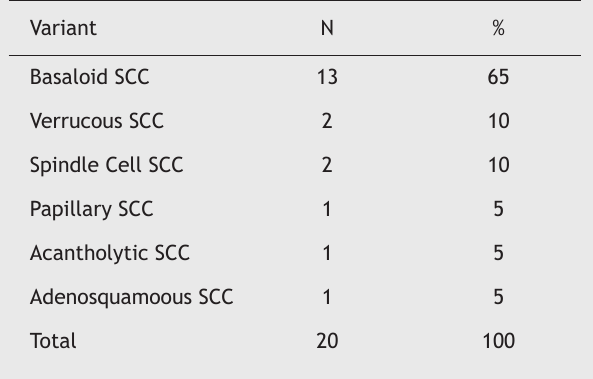
Table 1 The distribution of variants larynx squamous cell carcinoma (SCC).